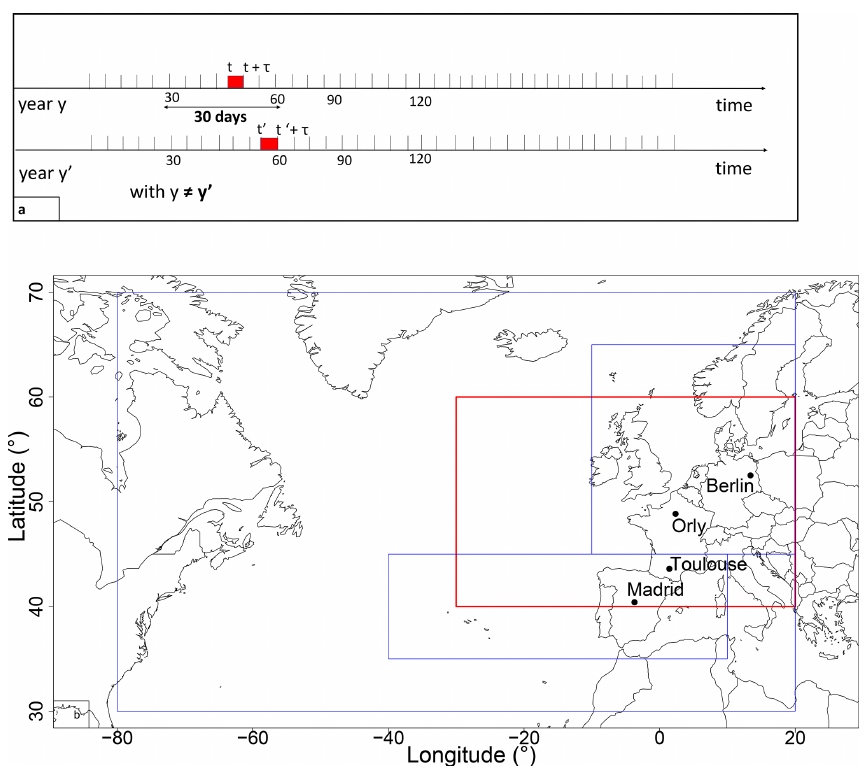
Figure 1. Parameters of the analog computation. (a) For each day t in year y , we chose an analog day t (cid:48) with a similar sequence of τ consecutive day Z 500 patterns. t 0 is selected within 30 calendar days of t and in a year y (cid:48) (cid:54)= y . (b) Domains of computation of analogs. We computed analogs over different domains, each one including a part of the Atlantic and focusing on a part of western Europe, in order to test the sensitivity of our model to different geographic areas. The optimizing area was [30 ◦ W–20 ◦ E; 40–60 ◦ N], indicated by the red